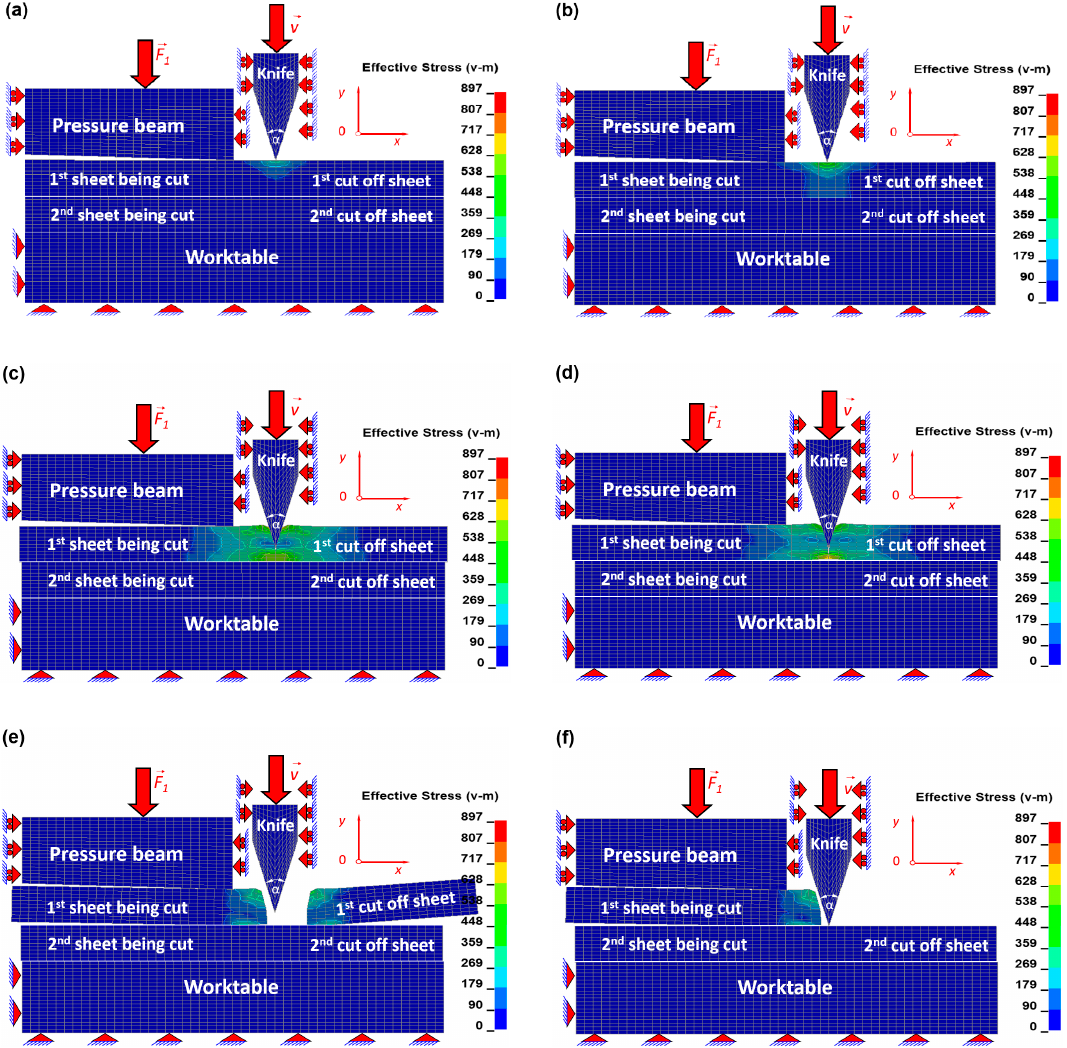
Figure 4. Contour maps of equivalent Huber–Mises stress [MPa] in the top sheet in a bundle being cut for the chosen time instants [ms]: ( a ) t = 2.04, ( b ) t = 2.07, ( c ) t = 8.00, ( d ) t = 8.40, ( e ) t = 8.43, and ( f ) t = 12.00.